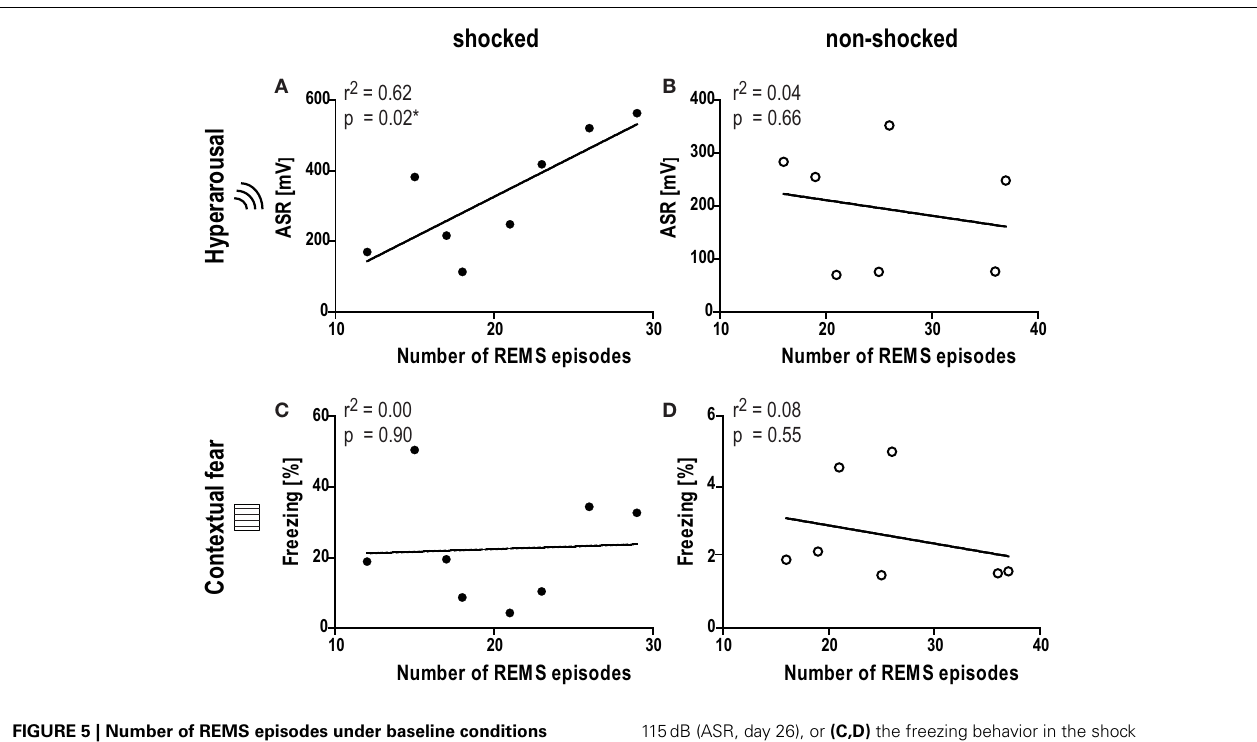
FIGURE 5 | Number of REMS episodes under baseline conditions is associated with the level of hyperarousal 1month after the trauma . Graphs show the correlation between the number of REMS episodes under baseline conditions in phase IV (day − 1, Zeitgeber time 18–24) and (A,B) the acoustic startle response at intensity of